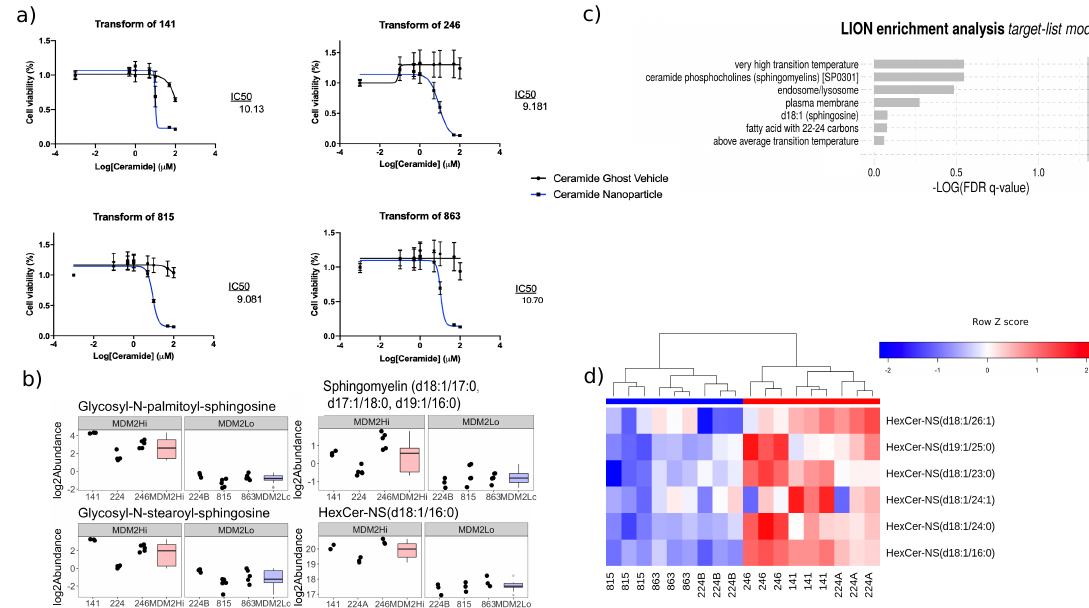
Figure 4. Ceramides are an important differentiator of DDLPS subtypes. ( a ) Treatment with ceramides is lethal to DDLPS cells, regardless of MDM2 status. ( b ) Glycosylated ceramides and lipids in the sphingolipid pathways were amongst the most altered lipids between MDM2 high and low cells in the metabolomic panel. ( c ) LIONenrichment analysis of terms associated with lipids found different between MDM2 higher and lower cells, untreated. ( d ) Hierarchical clustering of cell lines by abundance of all glycosylated ceramides in the lipidomic panel. For column colors, red is MDM2 higher and blue is MDM2